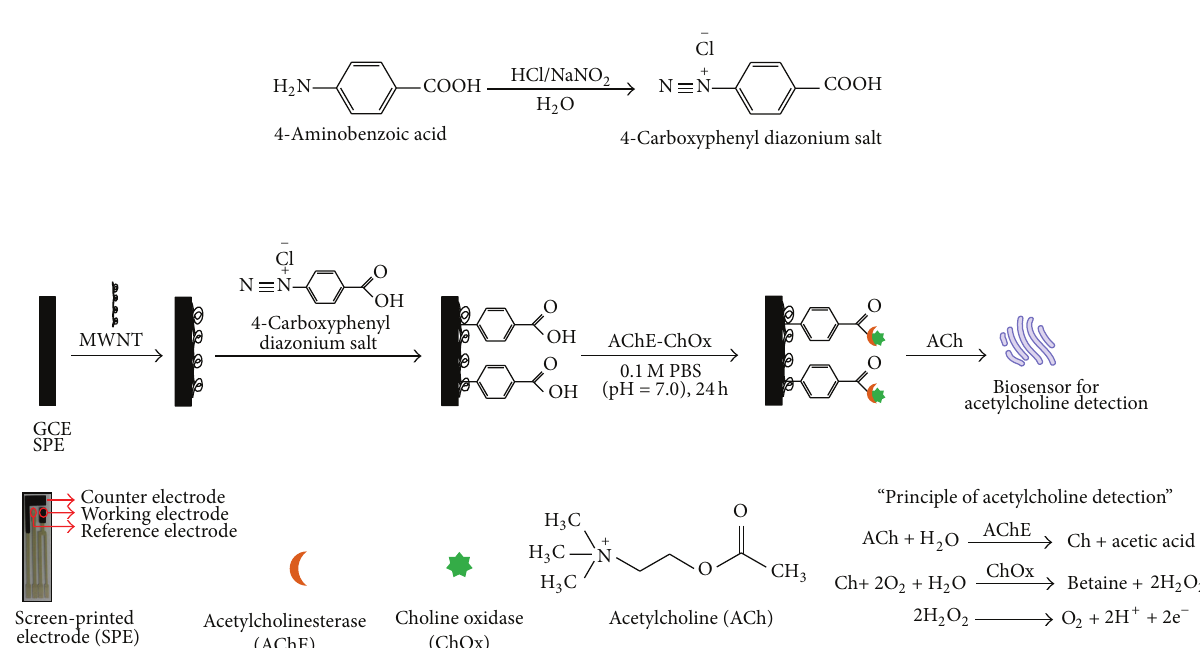
Figure 1: Schematic fabrication of the AChE-ChOx-modified biosensor based on a GCE and SPE.